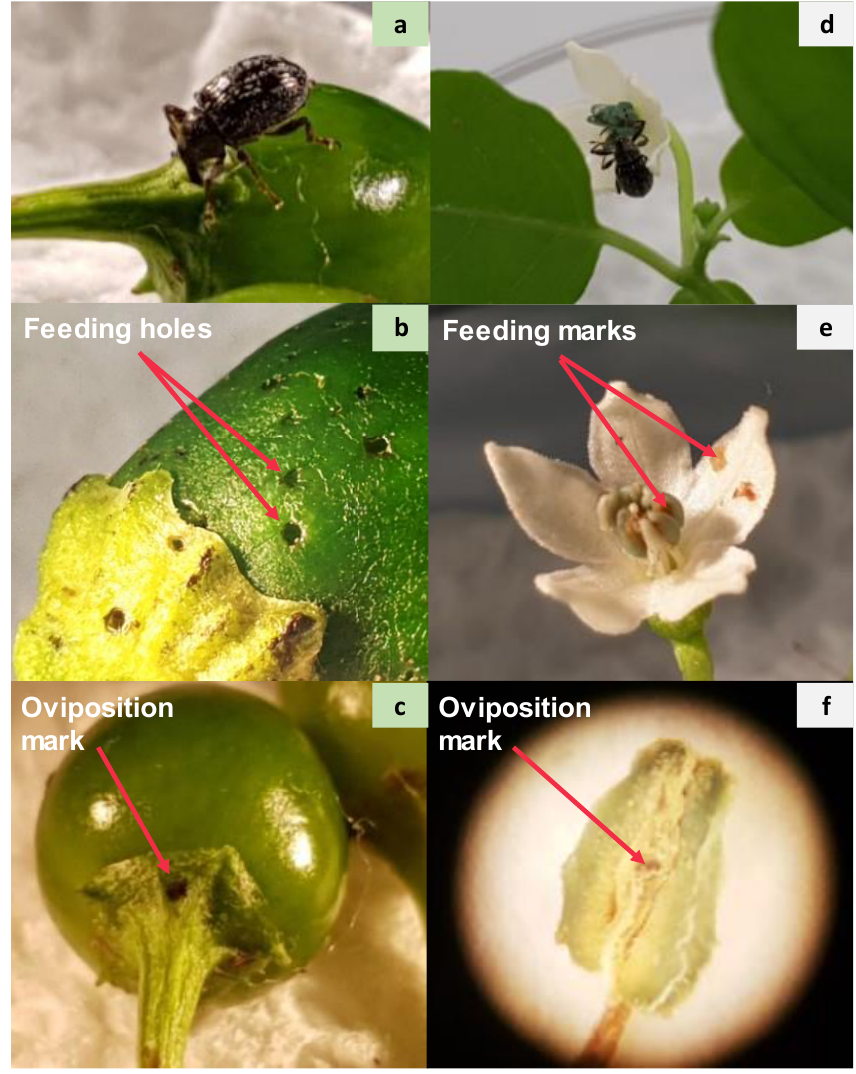
Figure 1. Pepper weevil damage on chili fruits ( a – c ) and flowers ( d – f ). All images © Y.